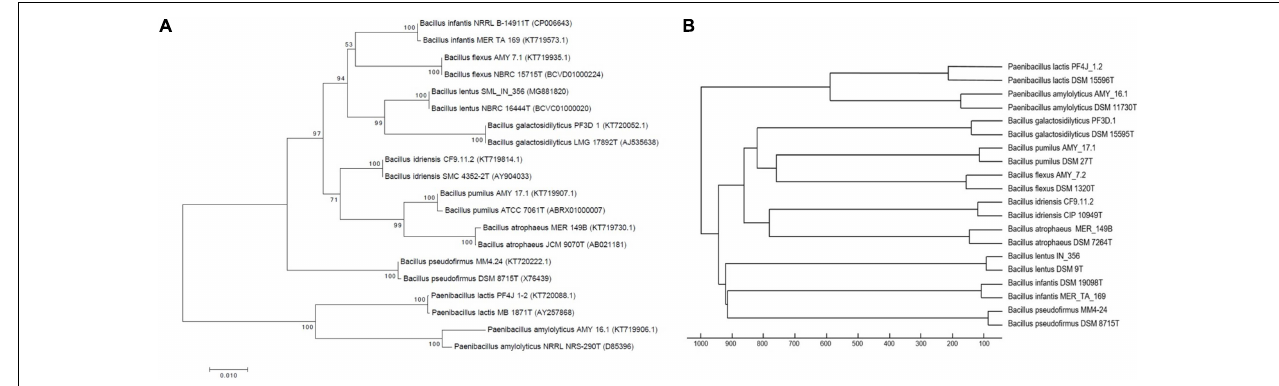
FIGURE 1 | Neighbor-joining tree based on nearly complete 16S rRNA gene sequences (A) and Hierarchical clustering using Euclidean distance and average linkage algorithm of mass spectra (B) of 10 isolates from the PP archive and corresponding type strains. Mass spectra of PP isolates cluster with corresponding type strain MSPs, in concurrence with 16S